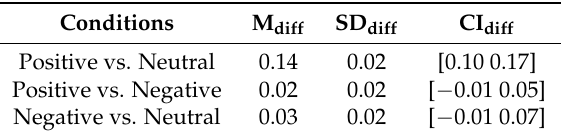
Table A12. Paired two-sample bootstrap test of significance (10,000 simulation runs) at 95.0% confidence interval (CI) applied on the participants’ PE5s (i.e., 62 PE5s associated with 62 EEG channels of a participant, per affect). Compared pairs of mental states are: positive versus neutral, positive versus negative, and negative versus neutral. M: mean difference, SD: standard deviation of the difference. CI: 95% confidence interval for every paired affective states’ difference.